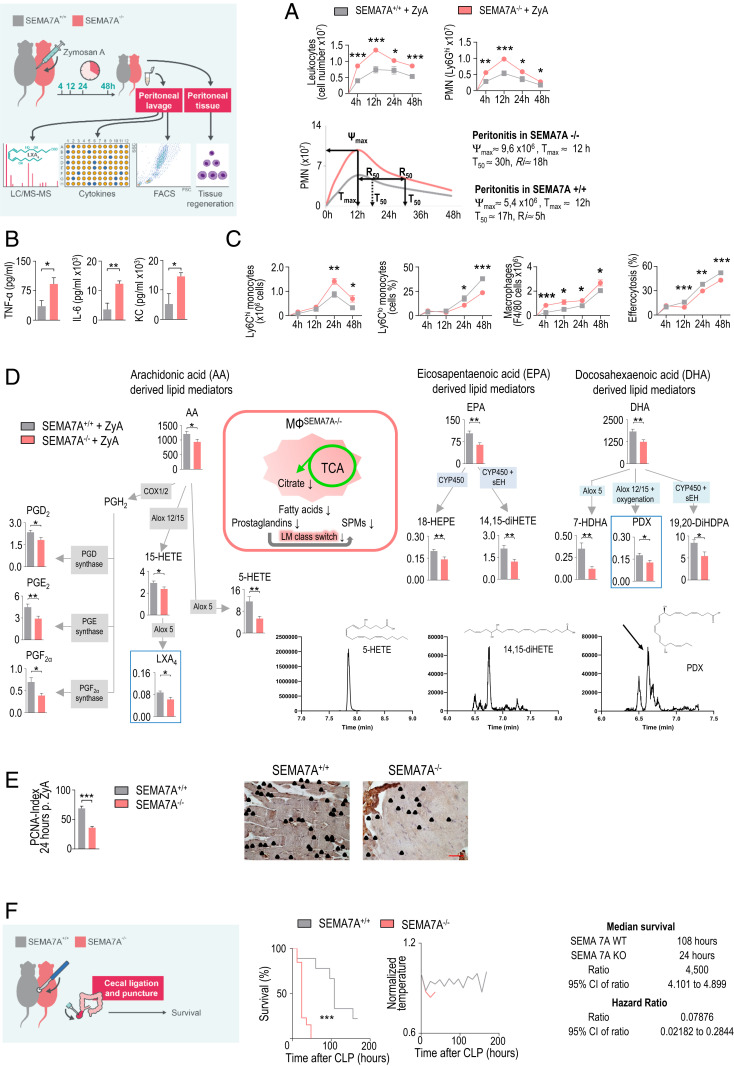
SEMA7A−/− mice display deficient inflammation resolution. Sema7A-deficient mice and littermate controls were injected with ZyA, and peritoneal lavages were collected at 4, 12, 24, and 48 h. (A) Total leukocytes were counted by light microscopy, and PMNs were identified by flow cytometry (n = 6 to 16). Resolution indices. (B) The cytokine levels of IL-1β, IL-6, and KC in peritoneal fluids were measured by enzyme-linked immunosorbent assay (ELISA) (n = 5 to 6). (C) Classical and nonclassical monocytes and MΦs as well as monocyte-derived MΦ efferocytosis were quantified by flow cytometry (n = 6 to 16). (D) The levels of bioactive lipid mediators and precursors derived from arachidonic acid (AA), docosahexaenoic acid (DHA), and eicosapentaenoic acid (EPA) in the peritoneal fluids of SEMA7A+/+ and SEMA7A−/− animals treated with ZyA (n = 15 to 19) for 4 h were quantified by LC-MS/MS–based profiling. (E) PCNA expression in peritoneal slices (24 h after ZyA injection) as detected by immunohistochemistry (n = 4) and the calculated indices (40× magnification). (Scale bar: 50 µm.) (F) Survival rates and normalized body temperatures of SEMA7A+/+ and SEMA7A−/− animals that underwent the CLP procedure with median survival and hazard ratios (WT: n = 9; KO: n =13). The results represent at least two independent experiments and are expressed as the mean ± SEM (A–E) and the geometric mean (F); significance was determined by the unpaired two-tailed Student’s t test (A–E) or log-rank test (F). *P < 0.05; **P < 0.01; ***P < 0.001.